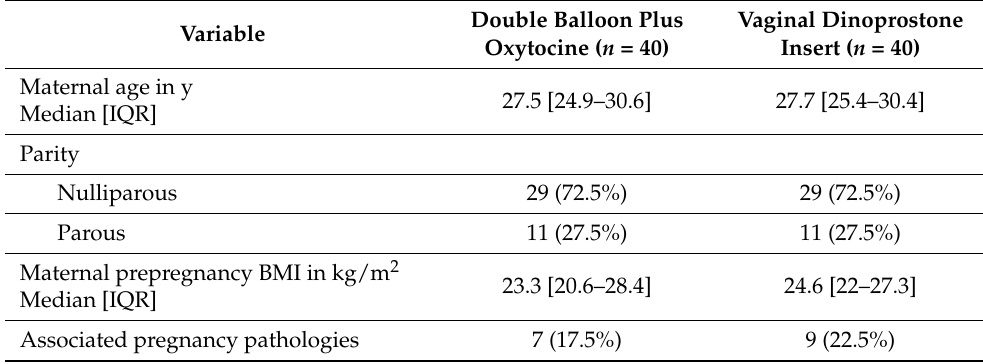
Table 1. Demographic and antenatal characteristics.